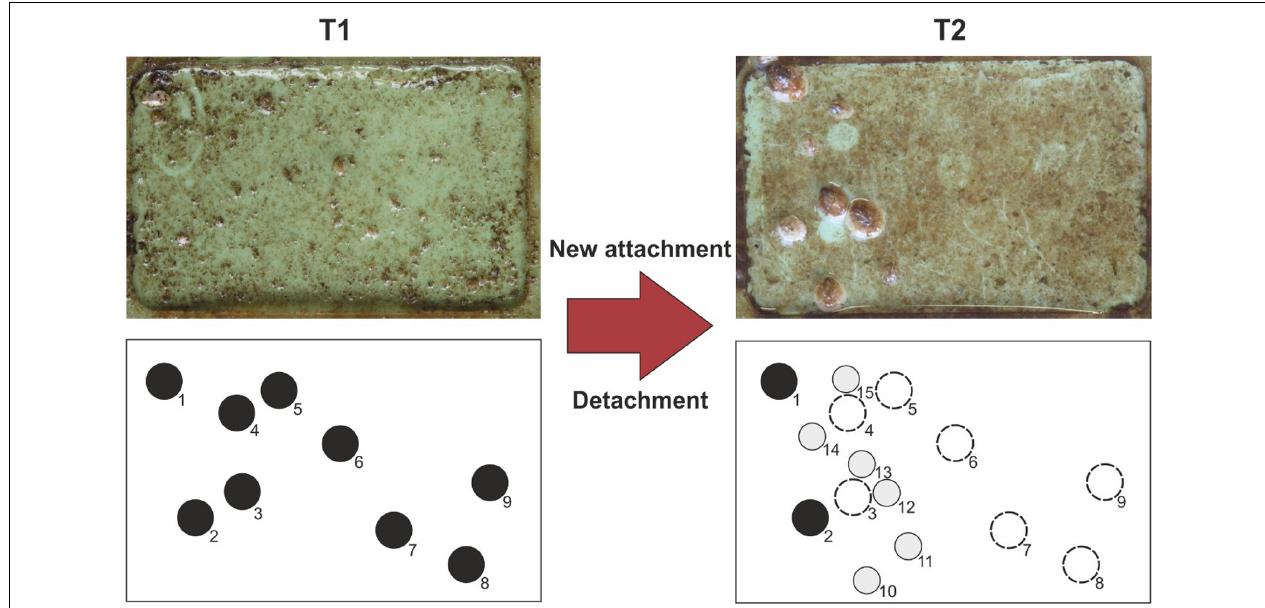
FIGURE 2 | Actual photos taken during the field experiment and an scheme showing the fouling evaluation method. At a given time T1 (here week 4), barnacles (black circles) are counted and indexed. At a later time T2 (here week 16), all detachment events are tracked (dashed circles). All newly attached barnacles (gray circles) are again tracked and indexed. The time interval used in this study between each fouling evaluation was 1 week. The entire field experiment took 17 weeks. Mussels were not considered during fouling